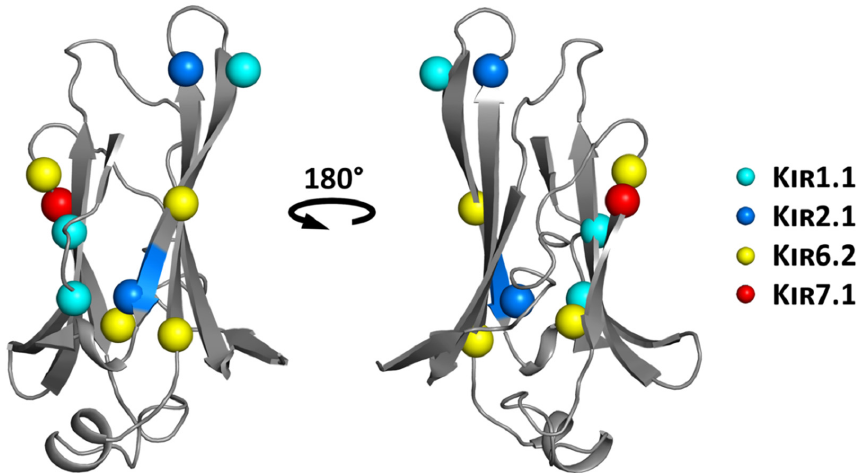
Figure 7. Structure-based IgLD hotspot (mapped on the K IR 2.2 structure), with disease associated mutations highlighted. Mutations of the di ff erent family members are color-coded and shown as spheres of their respective C α atoms.